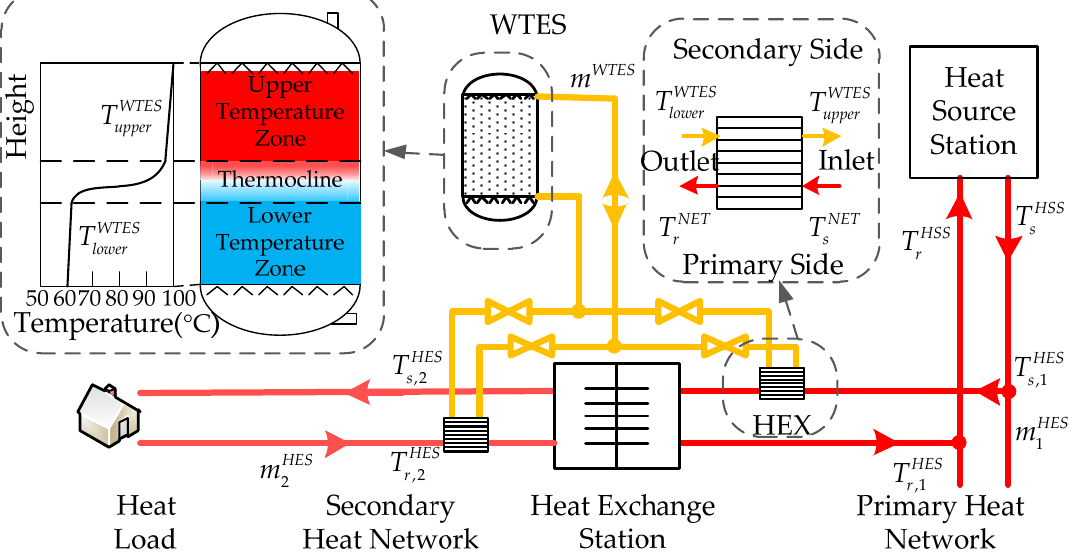
Figure 1. Medium temperature zones and device connections of a WTES system.